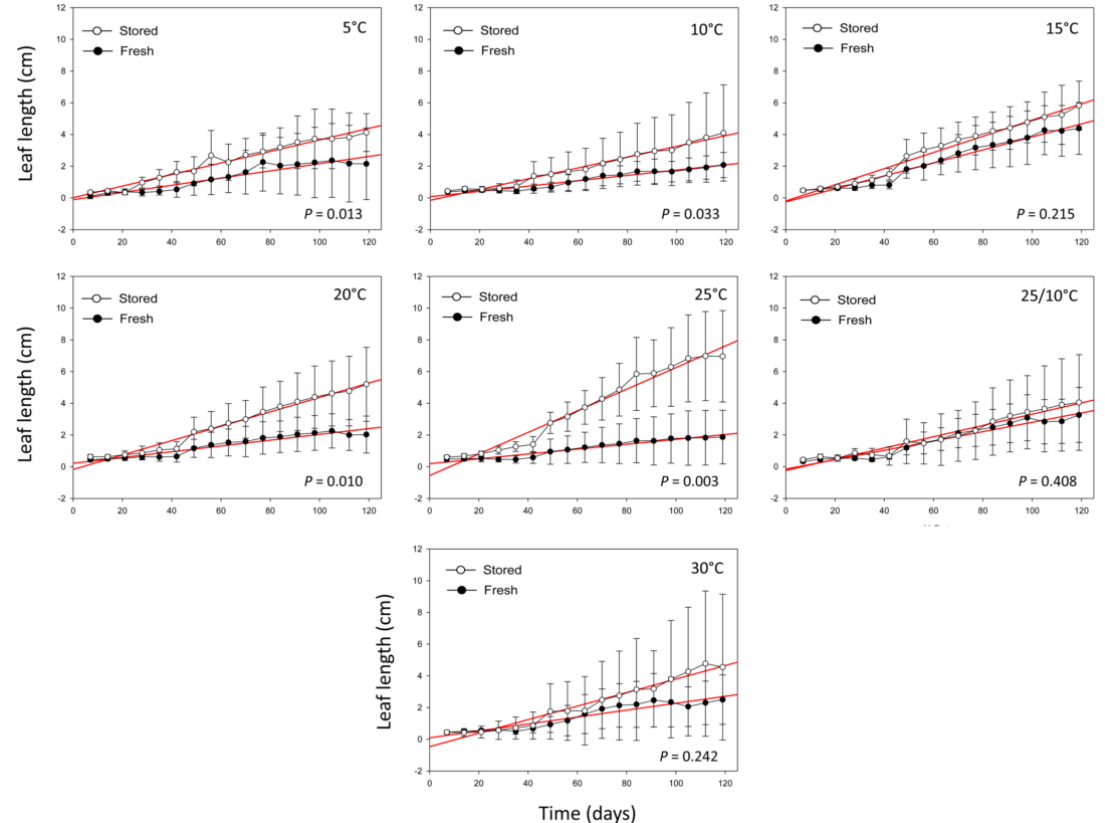
Figure 2. Seedling growth, expressed as leaf length measured, by plants obtained from germinated seeds in each incubation temperature and seed condition (stored and fresh). Measures of leaf length are expressed by time unit, according to the following equation: unit = cm × day − 1 . Red lines correspond to linear regressions.